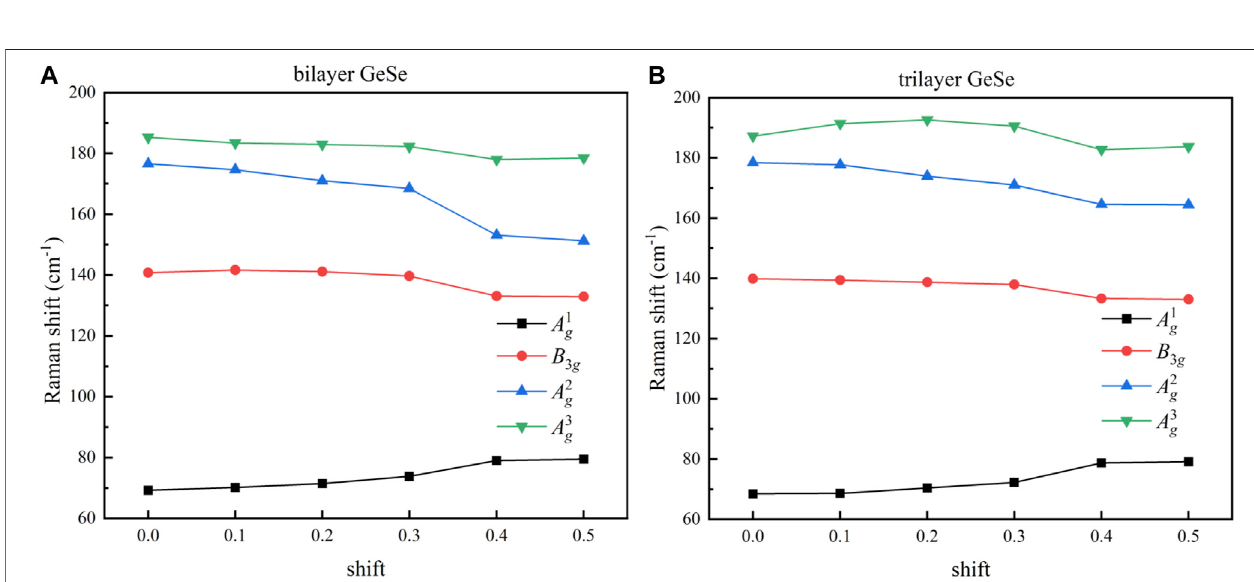
FIGURE 5 | The activate Raman frequency related to the evolution structures for (A) bilayer and (B) trilayer GeSe in Figure 4 .